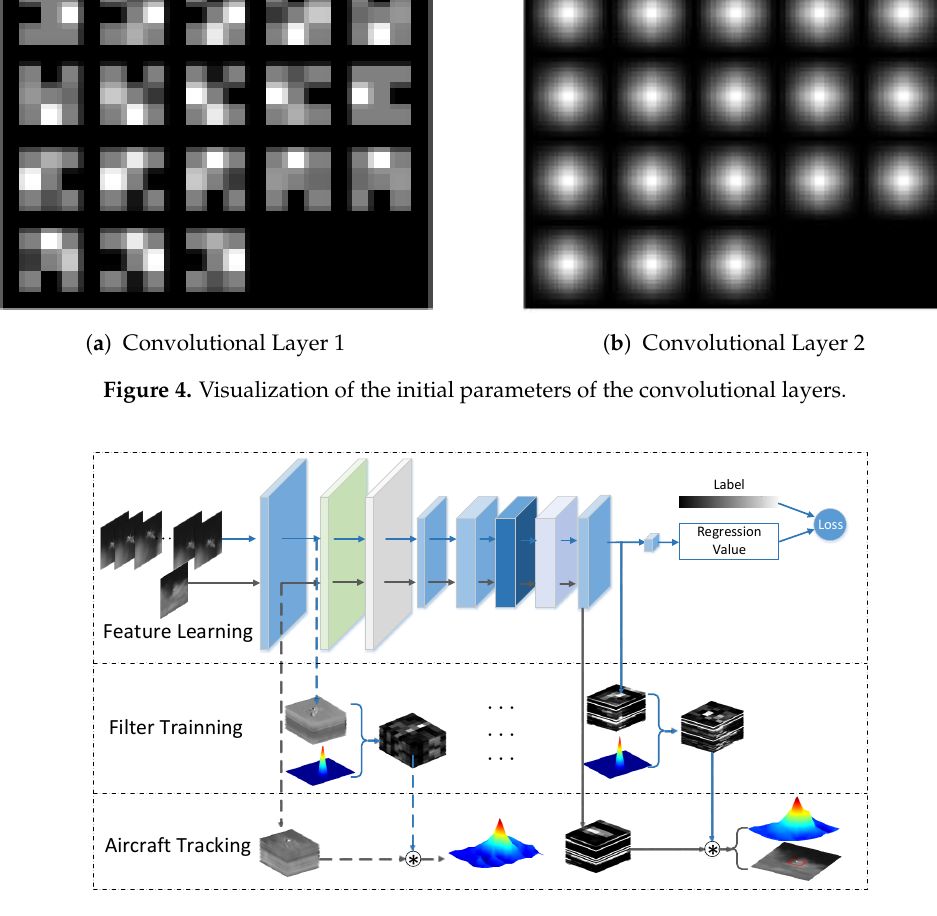
Figure 5. The procedure of the proposed tracker. The process of feature learning is achieved by training the network based on Equation (1). The learned features are integrated into the correlation filter tracking